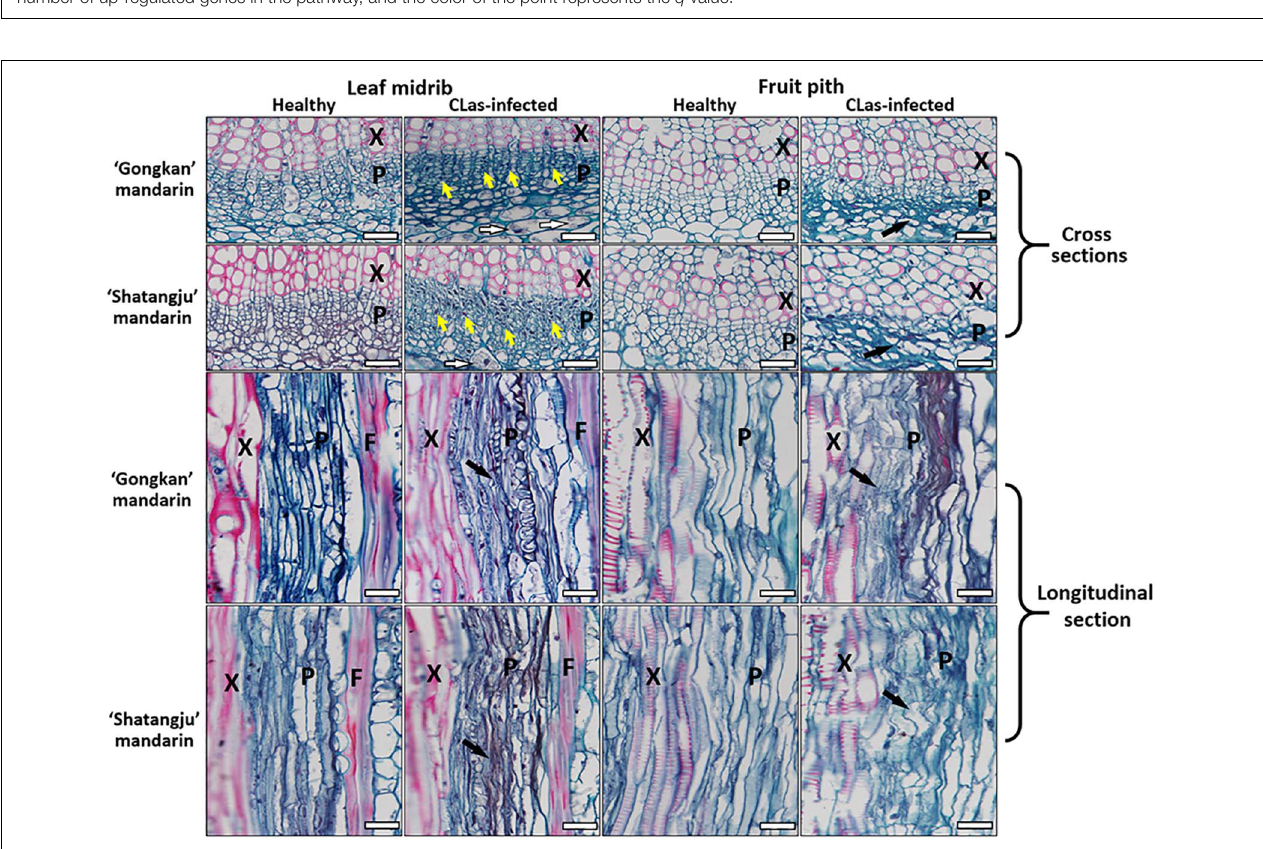
FIGURE 6 | KEGG enrichment analyses of the up-regulated genes in “ Candidatus Liberibacter asiaticus” (CLas)–infected leaf midribs (A) and CLas-infected fruit pith (B) . The vertical coordinates represent the enriched pathways, and the horizontal coordinates represent the rich factors. The size of each point represents the number of up-regulated genes in the pathway, and the color of the point represents the q value.